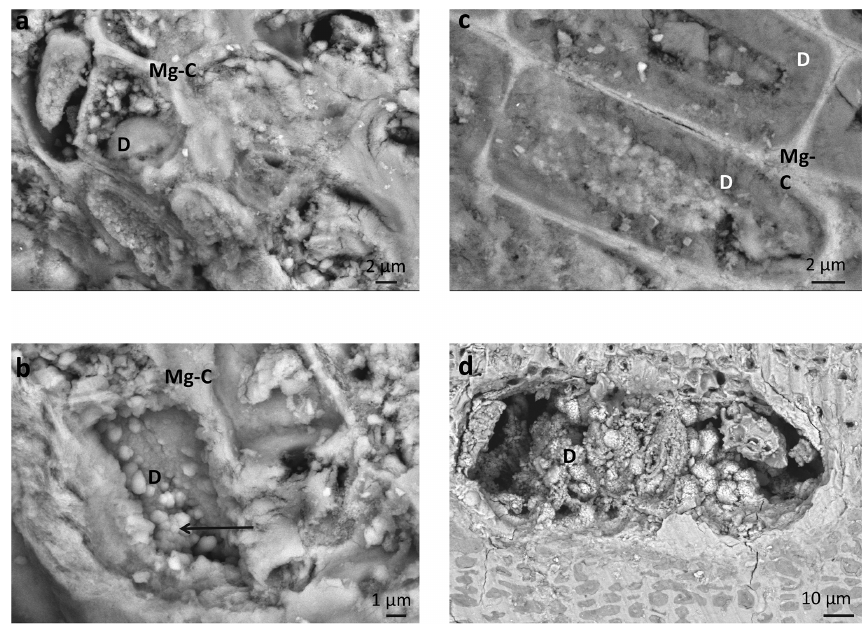
Figure 4. SEM (Backscatter – BSE) of control P. onkodes showing dolomite in experimental and pre-experimental growth. BSE SEM shows the lighter elements, i.e. magnesium, as darker grey and heavier elements, i.e. calcium is pale grey to white. Secondary electron images show the topography of the sample but do not provide information on the elemental composition. EDS measurements are made in the different grey shade areas to measure Mg composition (range listed in supplement) and this is used to identify the mineral composition. Once the measurements have been made it is possible then to identify dolomite and calcite from the grey shade. (a) Experimental growth, dolomite (D) Dolomite-composition material in cell. This is not the typical cell lining but has been observed in other CCA. Mg-calcite (Mg-C). Scale = 2 microns. (b) Experimental growth: micro-scale lumpy dolomite lining cell. Scale = 1 micron. Cell growth in experimental growth is less regular and organised than pre-experimental growth. (c) Dolomite cell lining in pre-experimental growth. Notice the very narrow cell walls. (d) Dolomite infill in a reproductive conceptacle in the old growth. Cells below conceptacle are all in-filled with dolomite. Scale bars: (a) and (c) = 2 microns, (b) = 1 micron, (d) = 10